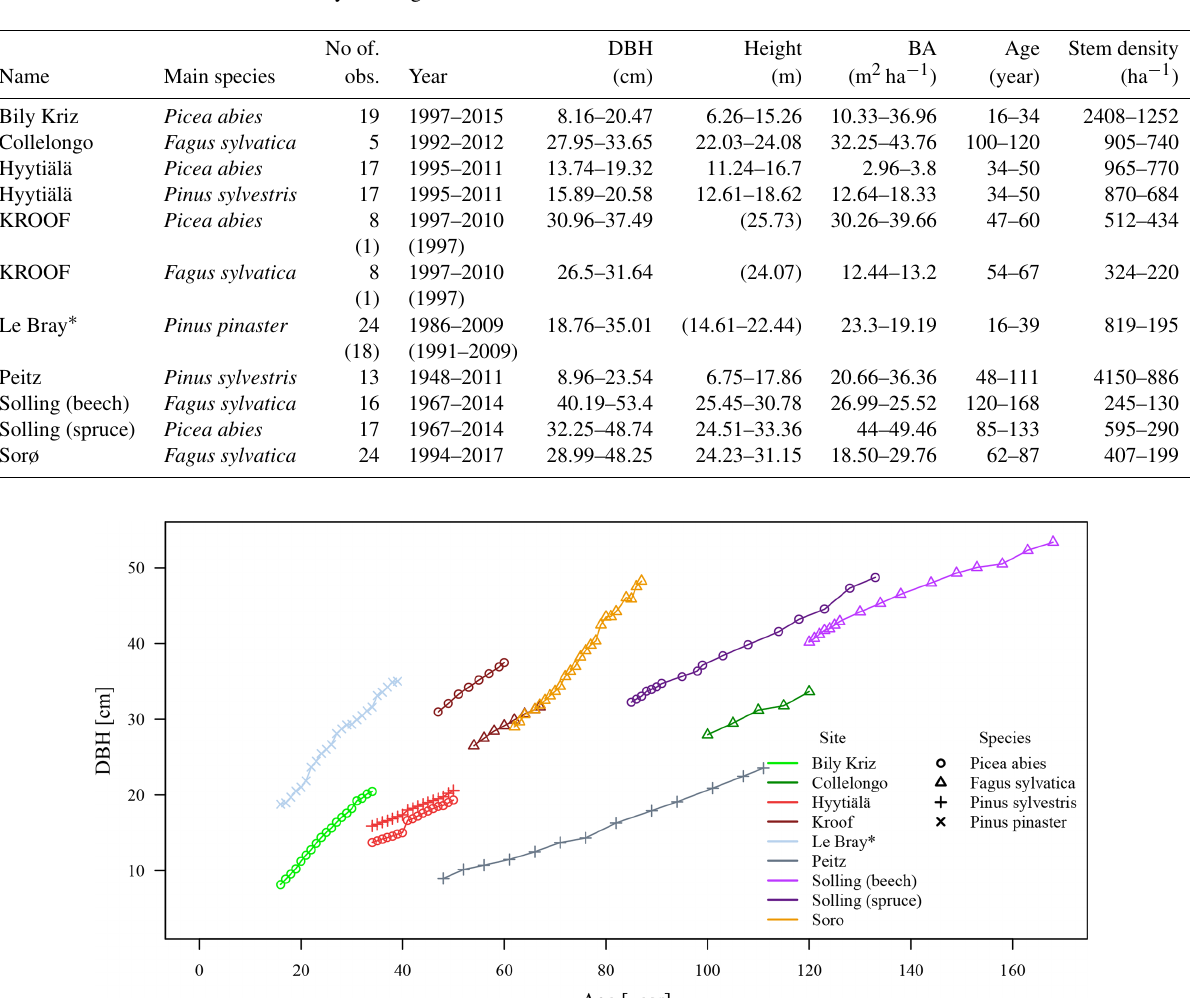
Table 4. Summary of the main stand variables for the forest stands in the PROFOUND DB. The first number in each cell indicates the value at the first measurement and the second number at the last measurement. The basal area-weighted mean height and DBH are shown for all stands with the exception of Le Bray for which the arithmetic mean height and DBH are shown (marked by asterisks). The numbers in brackets indicate different data availability for height than for the other variables.